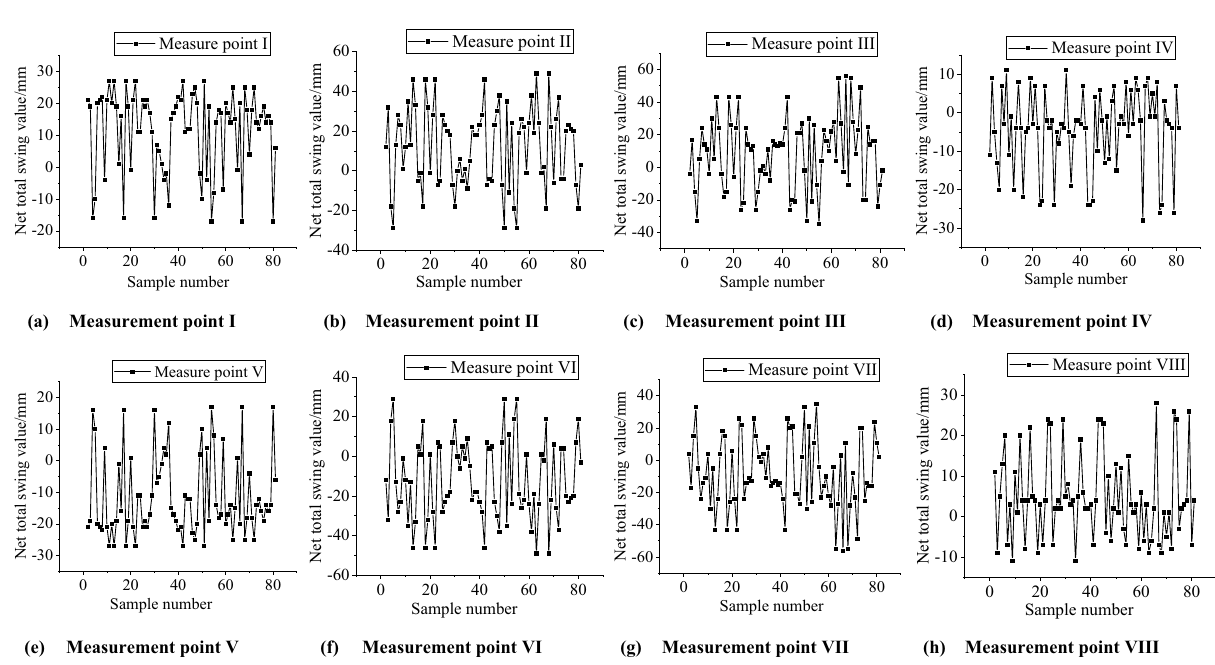
Figure 6. Trend of net full swing at eight measurement points on the